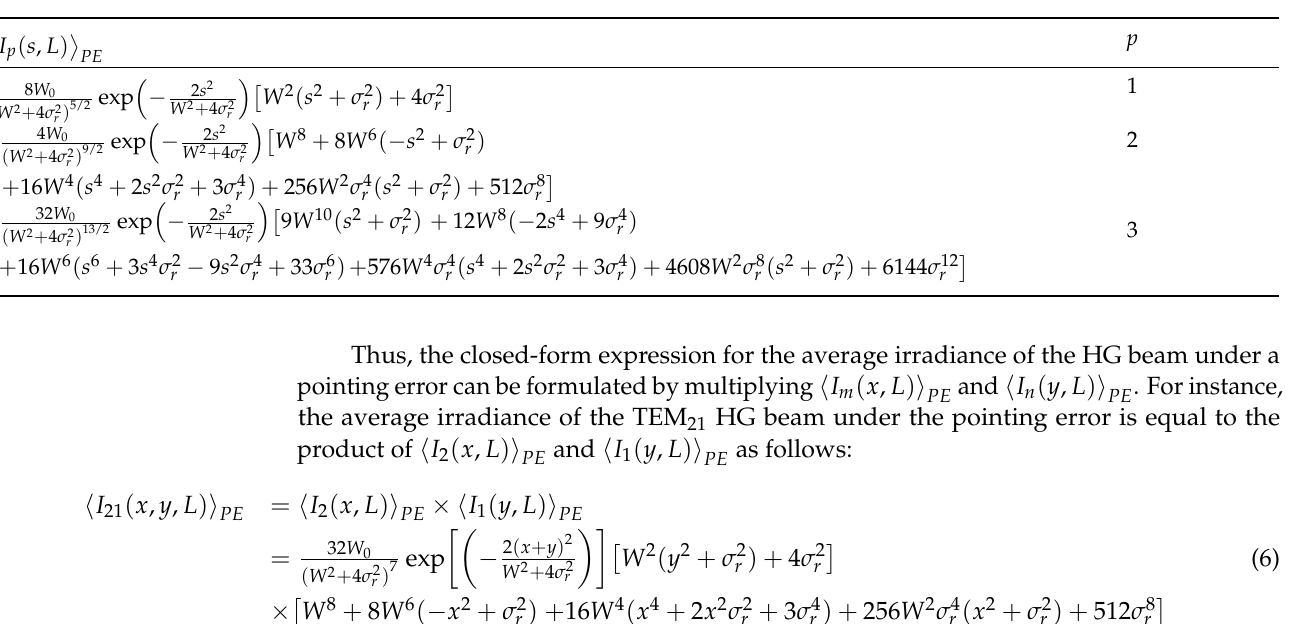
Table 1. Expression of